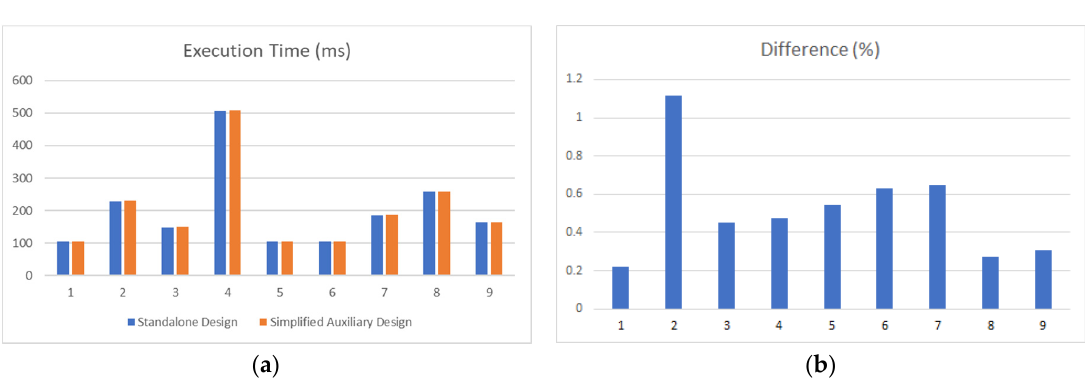
Figure 7. ( a ) Execution time of different test groups for the STM32F4 instruction types measured using the standalone design and the simplified auxiliary design. ( b ) Difference (%) between the standalone design and the simplified auxiliary design.